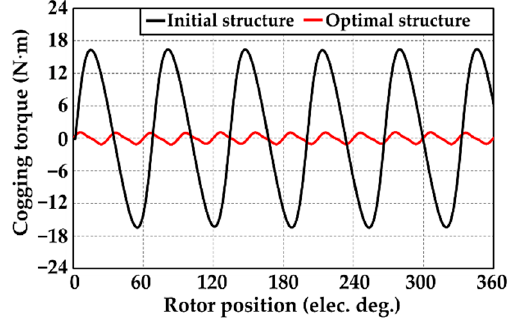
Figure 10. Comparison of cogging torque.